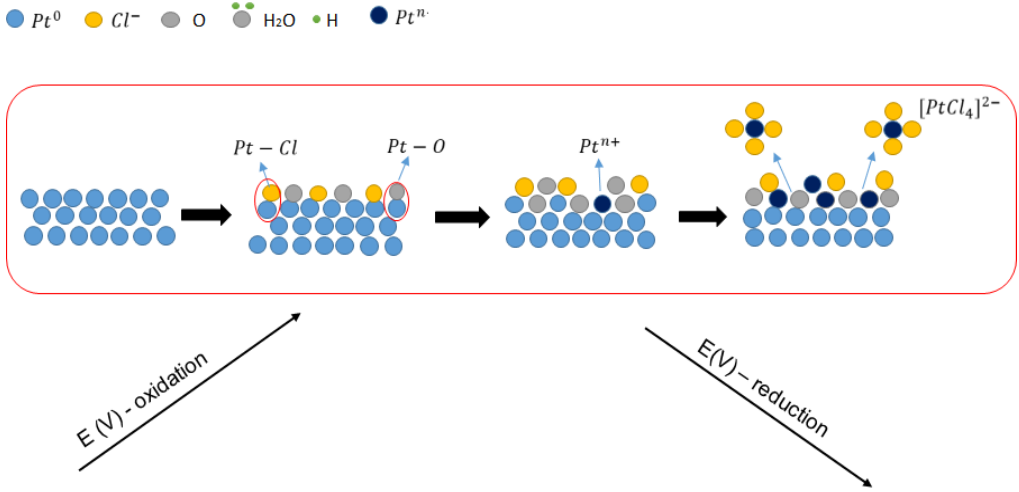
Figure 7. The process of electrochemical dissolution of platinum.